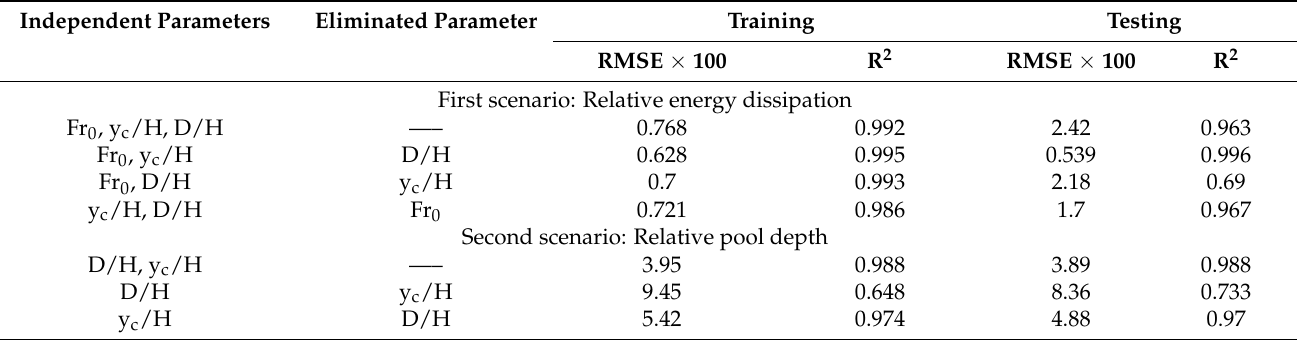
Table 7. Sensitivity Analysis.